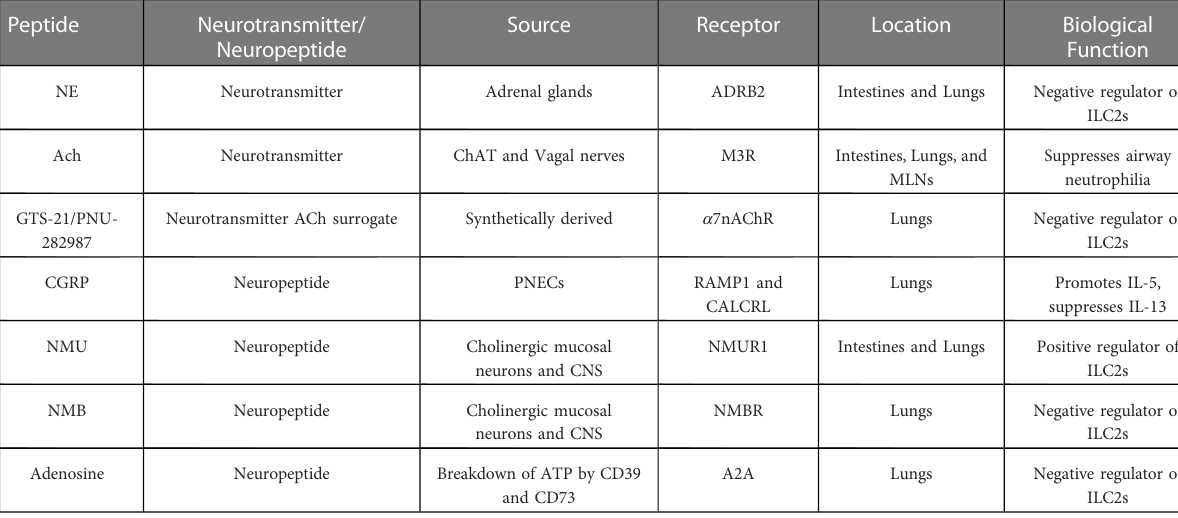
TABLE 1 Biological function of neurotransmitters and neuropeptides in mice.